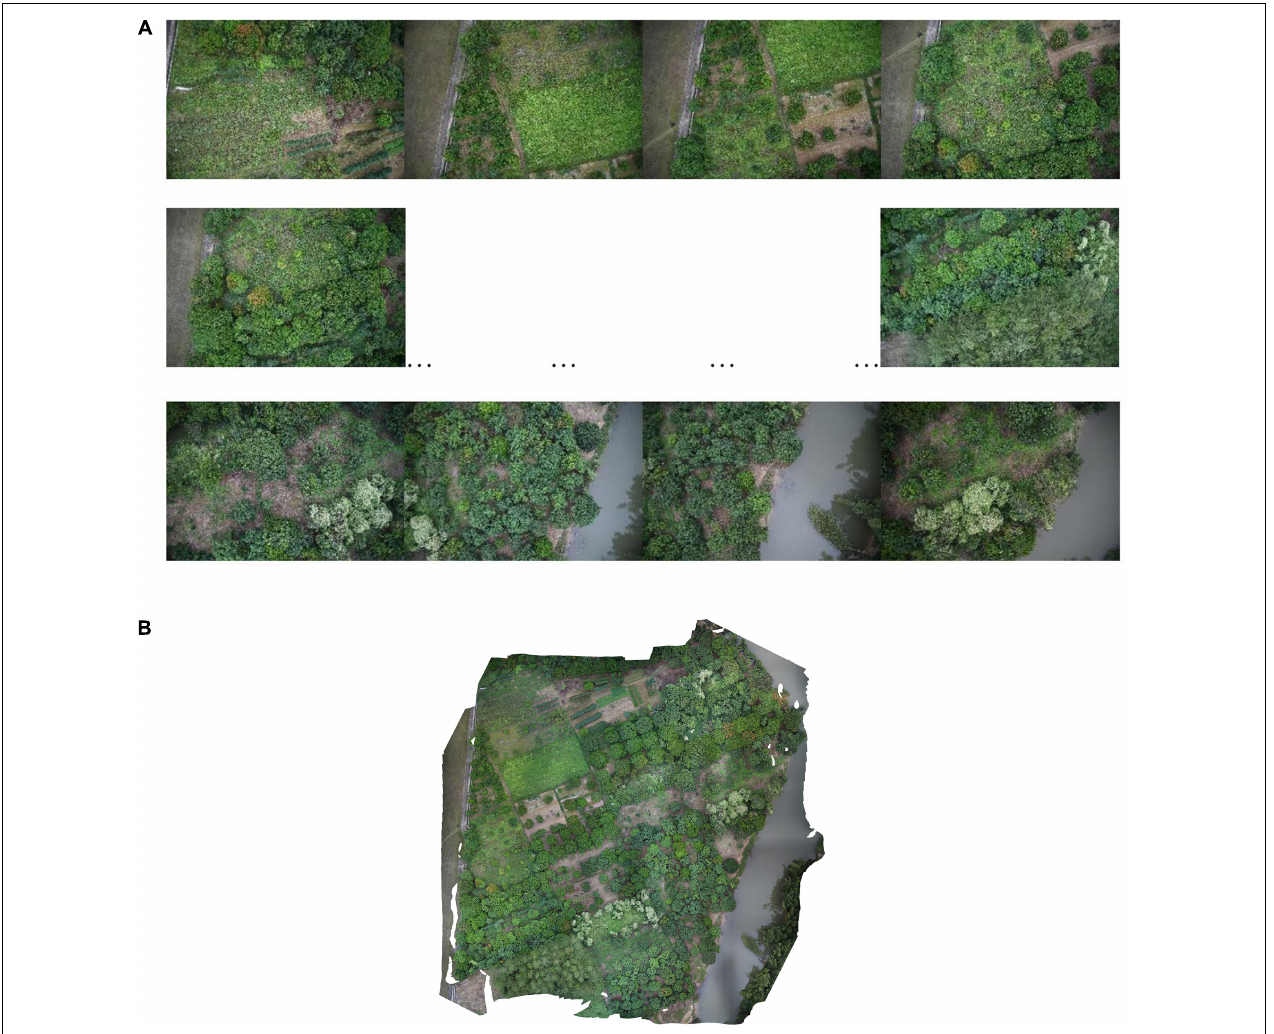
FIGURE 4 | RGB imagery datasets were processed using the software Agisoft PhotoScan. (A) High-resolution proof images of the acquisition area. (B) Overall map of research area processed by Agisoft PhotoScan.